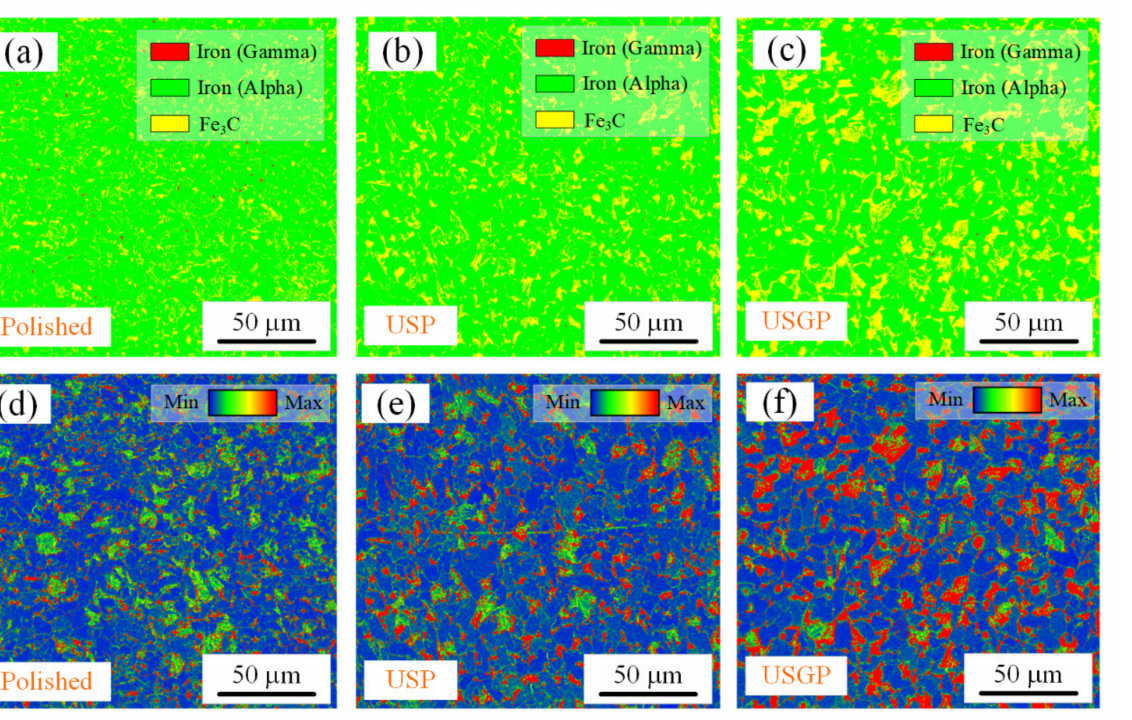
Figure 12. EBSD analyses for the distributions of phase and kernel average misorientation of samples’ cross-section. Phase distributions of polished ( a ), USP ( b ), and USGP samples ( c ); Kernel average misorientation distributions of polished ( d ), USP ( e ), and USGP samples ( f